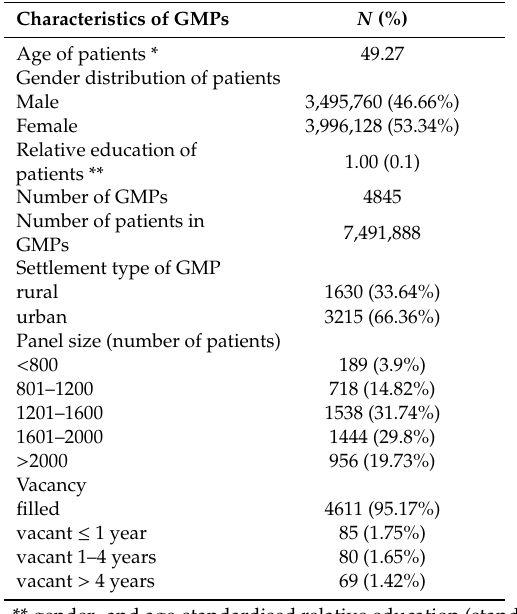
Table 2. Characteristics of general medical practices (GMPs) in 2015.